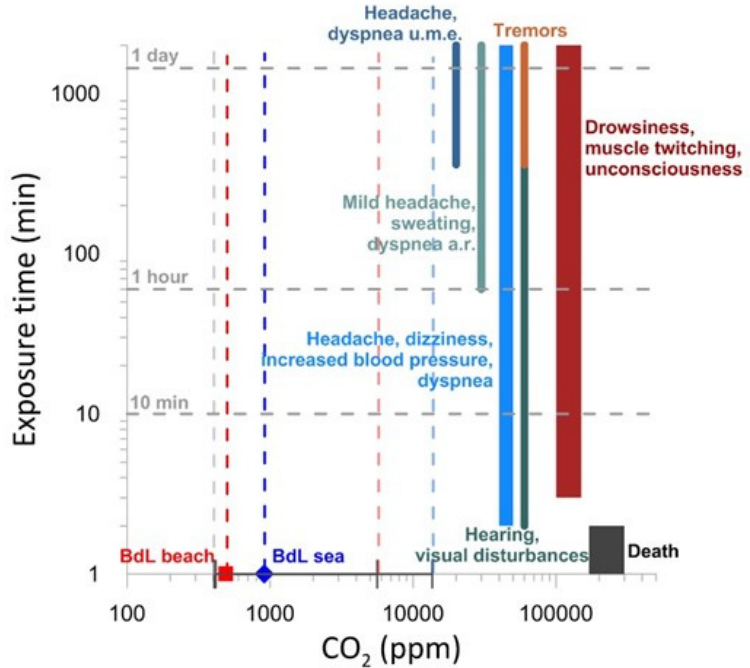
Figure 10. Atmospheric concentrations of CO 2 on the sea surface and on the beach of Baia di Levante area compared with associated human health risks (reference values available at https://www.epa.gov/sites/production/files/2015-06/documents/co2appendixb.pdf). Points indicate the average concentrations measured during the surveys. Blue and red vertical dashed lines represent average values for BdL beach and BdL sea, respectively. The grey vertical dashed line represents the minimum measured value for both BdL beach and BdL sea. Light blue and light red vertical dashed lines represent the maximum values measured at BdL sea and BdL beach, respectively. The acronyms u.m.e. and a.r. represent “upon mild exertion” and “at rest”, respectively.